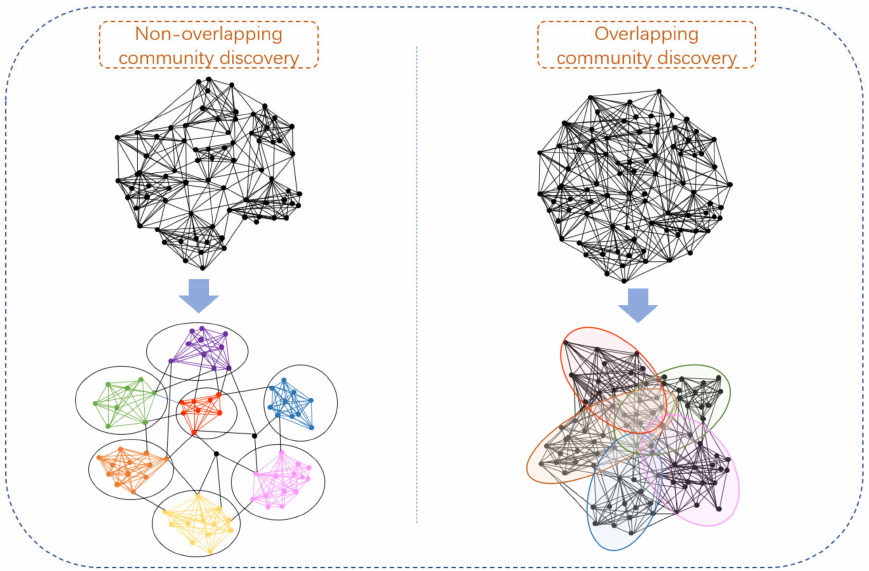
Figure 4. Schematic diagram of non-overlapping community discovery and overlapping commu- nity